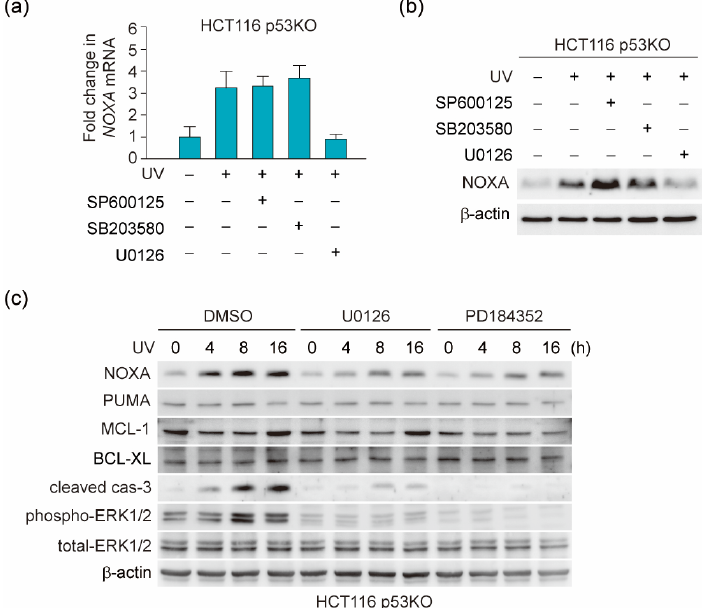
Figure 2. Extracellular signal-regulated kinase (ERK) activation induced by DNA-damage plays an important role in NOXA induction. ( a , b ) HCT116 p53 KO cells were treated for 30 min with 10 μM SP600125, 10 μM SB203580, or 20 μM U0126 prior to UV light (100 J/m 2 ) irradiation. After 24 h of irradiation, NOXA mRNA expression levels were measured by qPCR ( a ), or 20 μg of total cell lysates was subjected to immunoblot analysis with the indicated antibodies ( b ). Quantitative analysis of immunoblot results is shown in Supplementary Figure S2a. ( c ) HCT116 p53 KO cells were treated for 30 min with 20 μM U0126 or 5 μM PD184352 prior to UV light (100 J/m 2 ) irradiation. After the indicated irradiation time, cells were analyzed by immunoblot analysis with the indicated antibodies. Quantitative analysis of immunoblot results is shown in Supplementary Figure S2b.